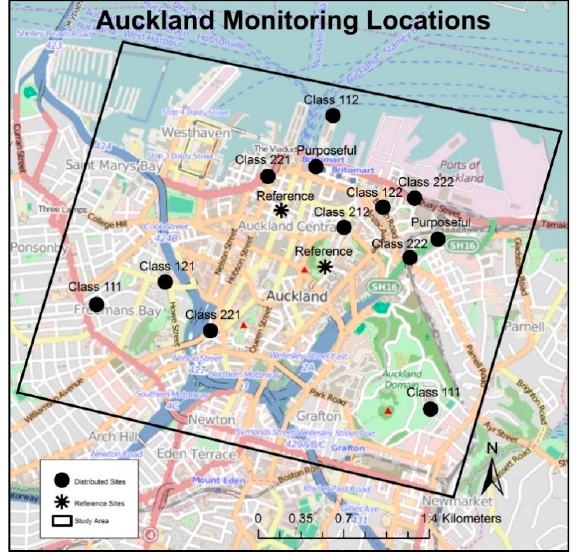
Figure 2. Distributed sampling sites across the study area. Classifications are, in order, traffic (1 = low, 2 = high), diesel (1 = low, 2 = high), and distance to port (1 = far, 2 = near).